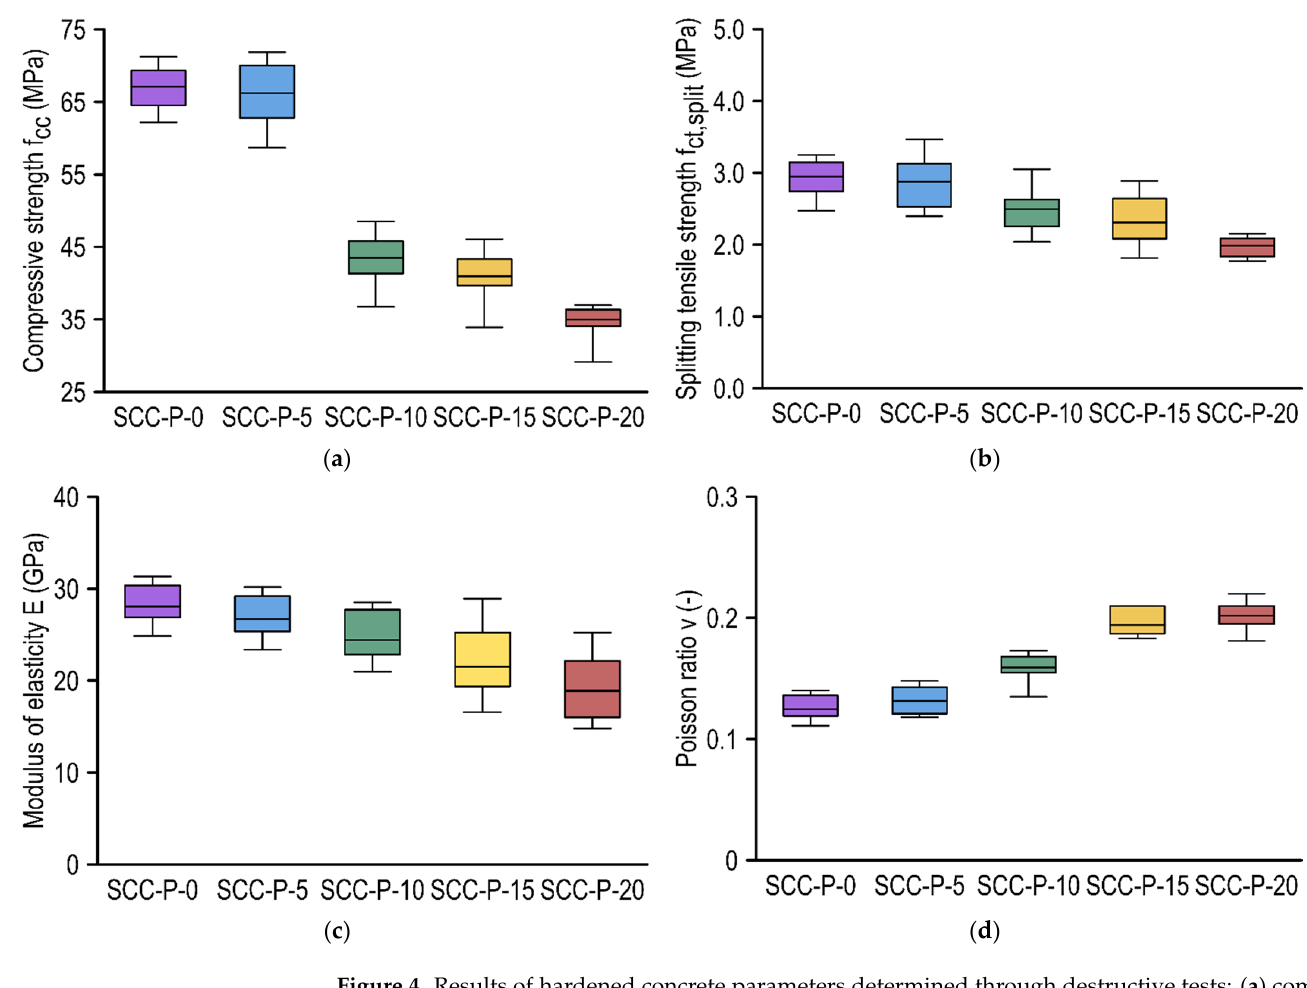
Figure 4. Results of hardened concrete parameters determined through destructive tests: ( a ) com- pressive strength, ( b ) splitting tensile strength, ( c ) modulus of elasticity, and ( d ) Poisson ratio. In whisker-box plots, the boxes are determined by quartiles (25% and 75%), the mid- point represents the mean of the results, and the minimum and maximum values of the test series are presented as whiskers. The results of the mechanical and deformation pa- rameters are presented in relation to the type of mixture.